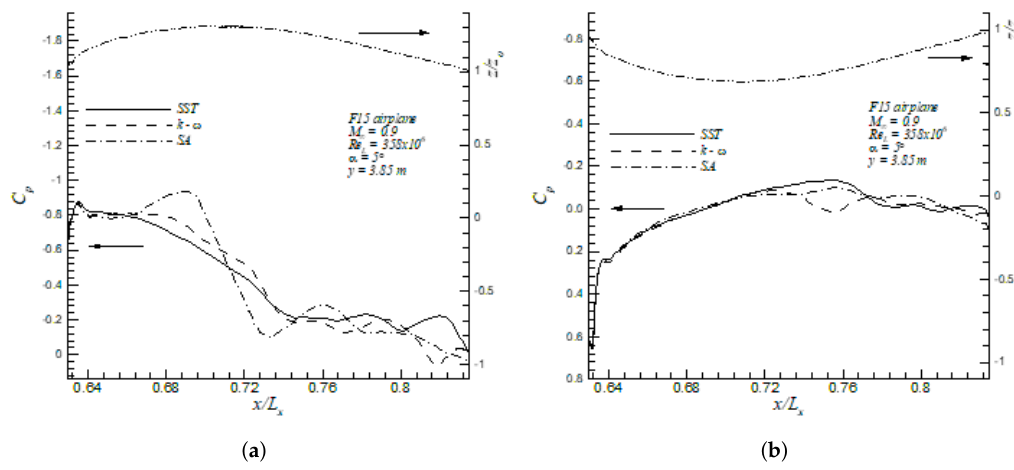
Figure 19. Pressure coefficients of F15 in the upper ( a ) and lower ( b ) surfaces at y / L y =